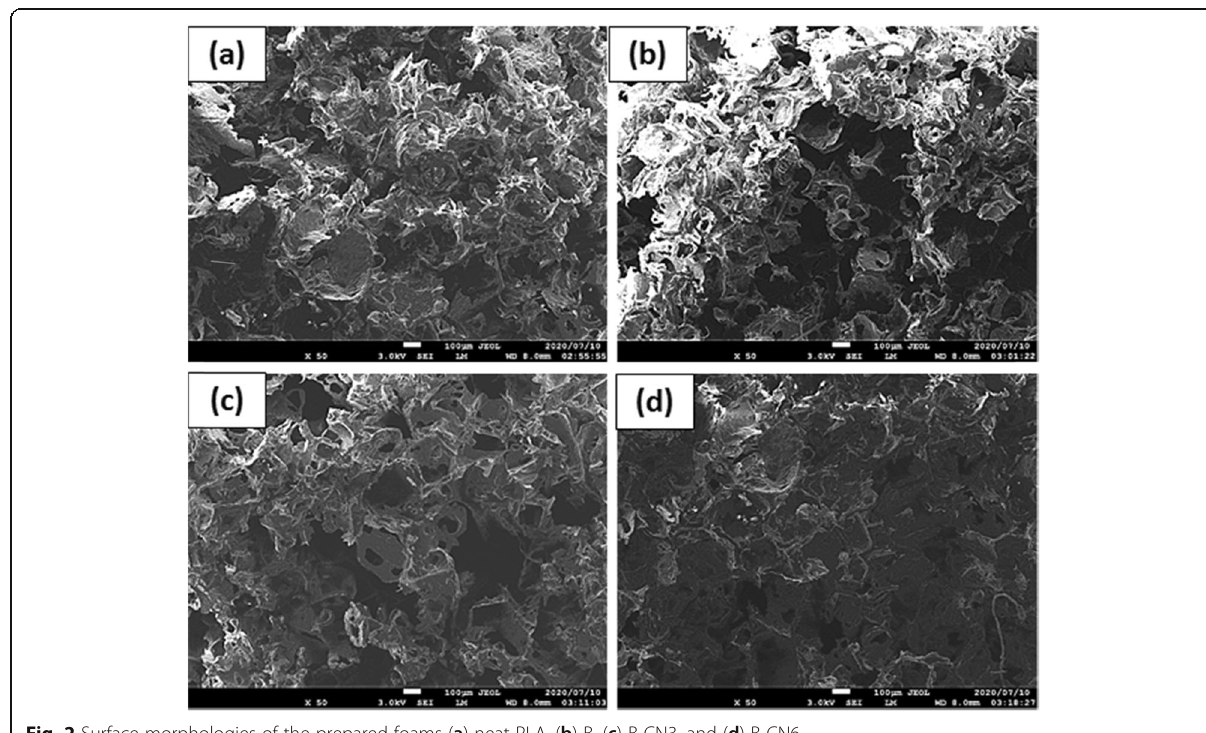
Fig. 2 Surface morphologies of the prepared foams ( a ) neat PLA, ( b ) B, ( c ) B-CN3, and ( d ) B-CN6